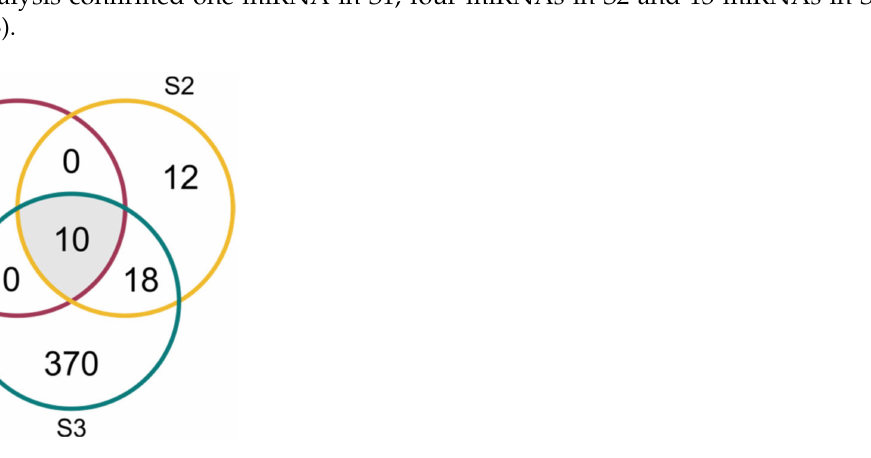
Figure 8. Venn diagram of targeted genes (with maximum expectation value ≤ 3) in three cucumber somaclonal lines (S1, S2 and S3). Table 3. Description of 10 target genes that were common to all three somaclonal lines and their miRNAs. C —regulation of gene expression by